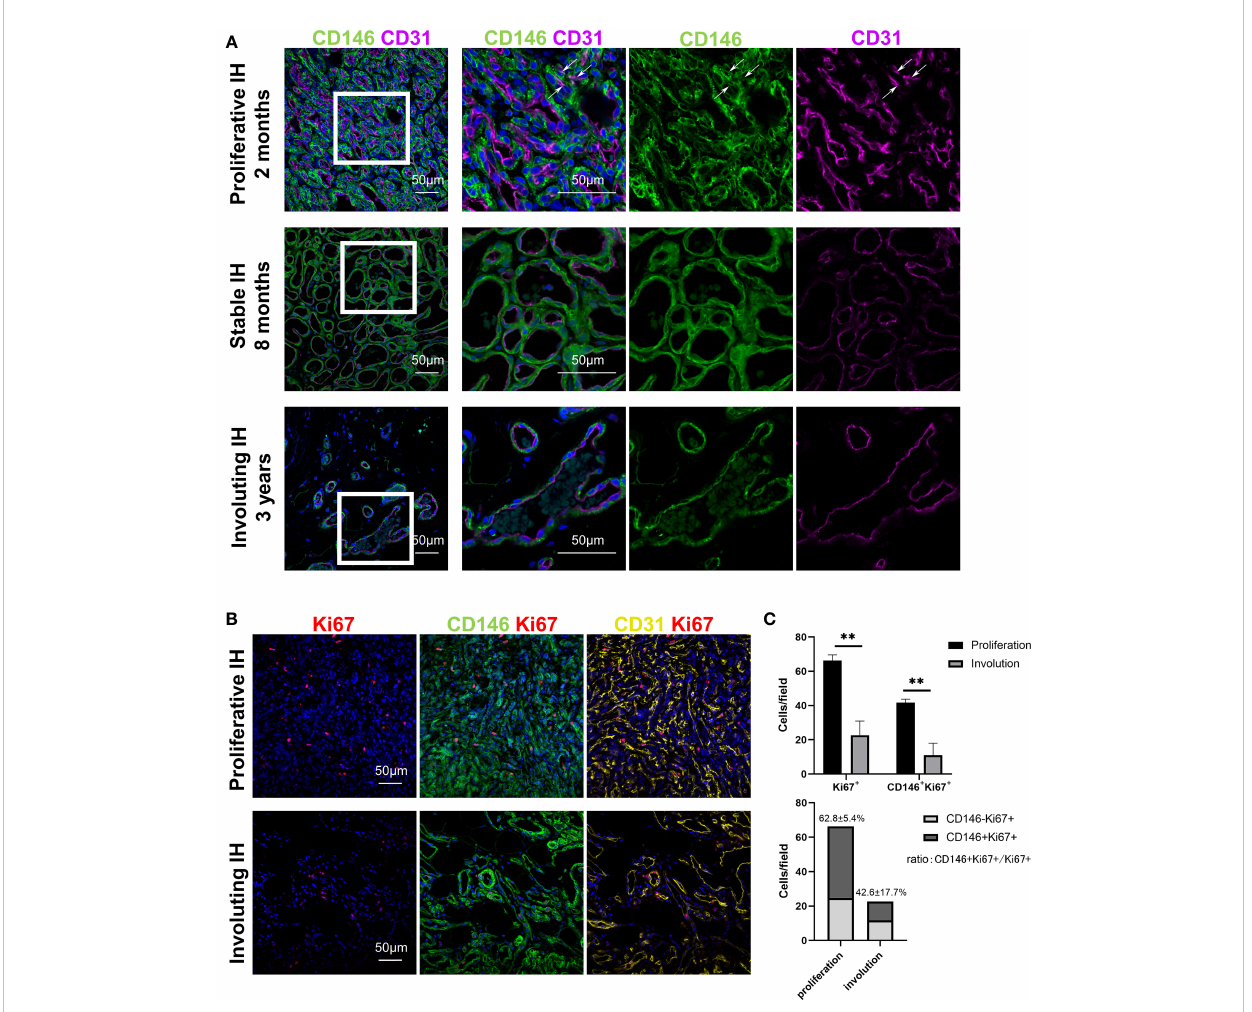
FIGURE 1 CD146 + cells are enriched in proliferative IH specimens. (A) Representative images of IH specimens stained for CD146 (green) and CD31 (magenta). A representative proliferative IH specimen was collected from a 2-month-old patient with rapid growth hemangioma. White arrows indicate the CD31 + HemECs with CD146 expression. A representative stable IH specimen was collected from an 8-month-old patient with a stable hemangioma. A representative involuting IH specimen was collected from a 3-year-old patient with involuted hemangioma. The results were con fi rmed in 18 patients. Short scale bars=50 m m; long scale bars=100 m m. ( B ) Representative images of proliferative and involuting IH tissue stained for Ki67 (red), CD146 (green), and CD31 (yellow). (C) Quanti fi cation of Ki67 + and CD146 + Ki67 + cells in proliferating and involuting IH tissue and proportions of CD146 + Ki67 + cells and CD146 - Ki67 + cells in total cells. Scale bars=50 m m. All nuclei were counterstained DAPI (blue). Data are expressed as the mean ± SDM. **, p <0.01. IH, infantile